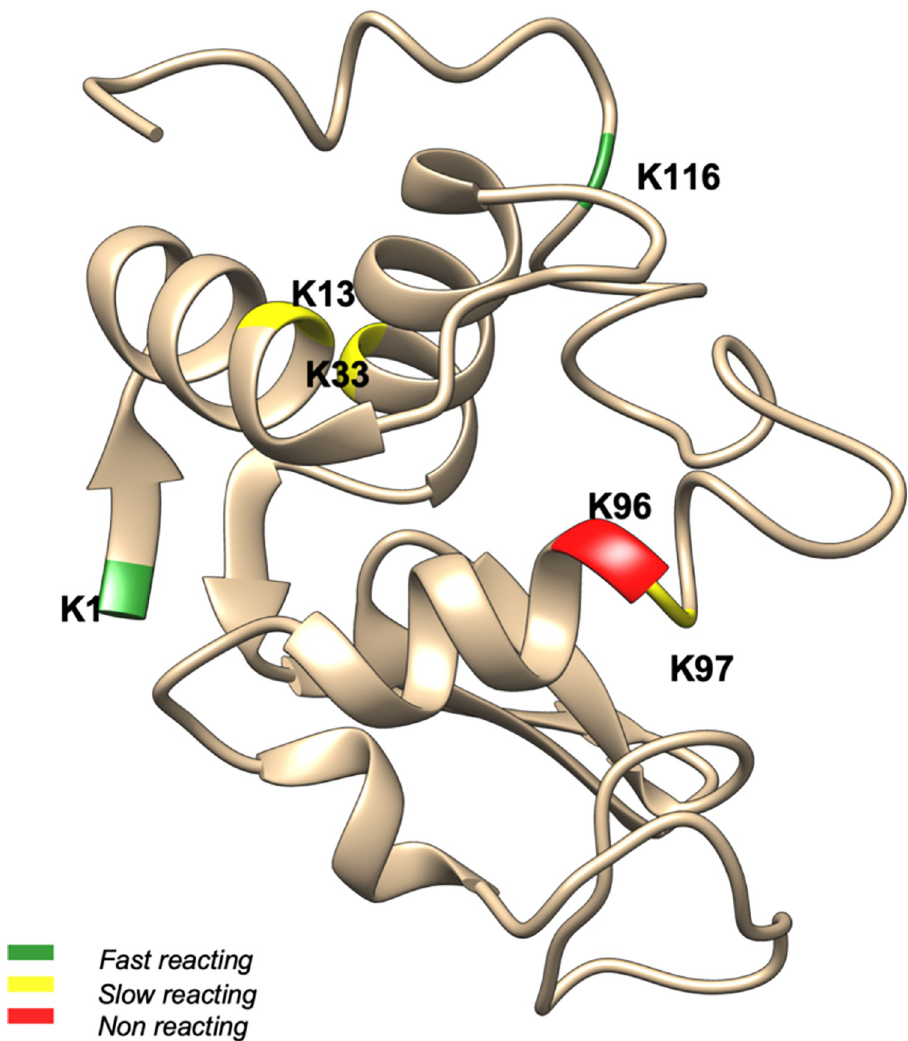
Fig 2. Predicted reactivities of lysozyme amino groups with ATRP initiator. The structure of lysozyme (PDB ID: 1LYZ) is presented using Chimera [15]. Lysine residues and N-termini are highlighted in green, yellow, and red to correspond to fast reacting, slow reacting, and non-reacting amino groups